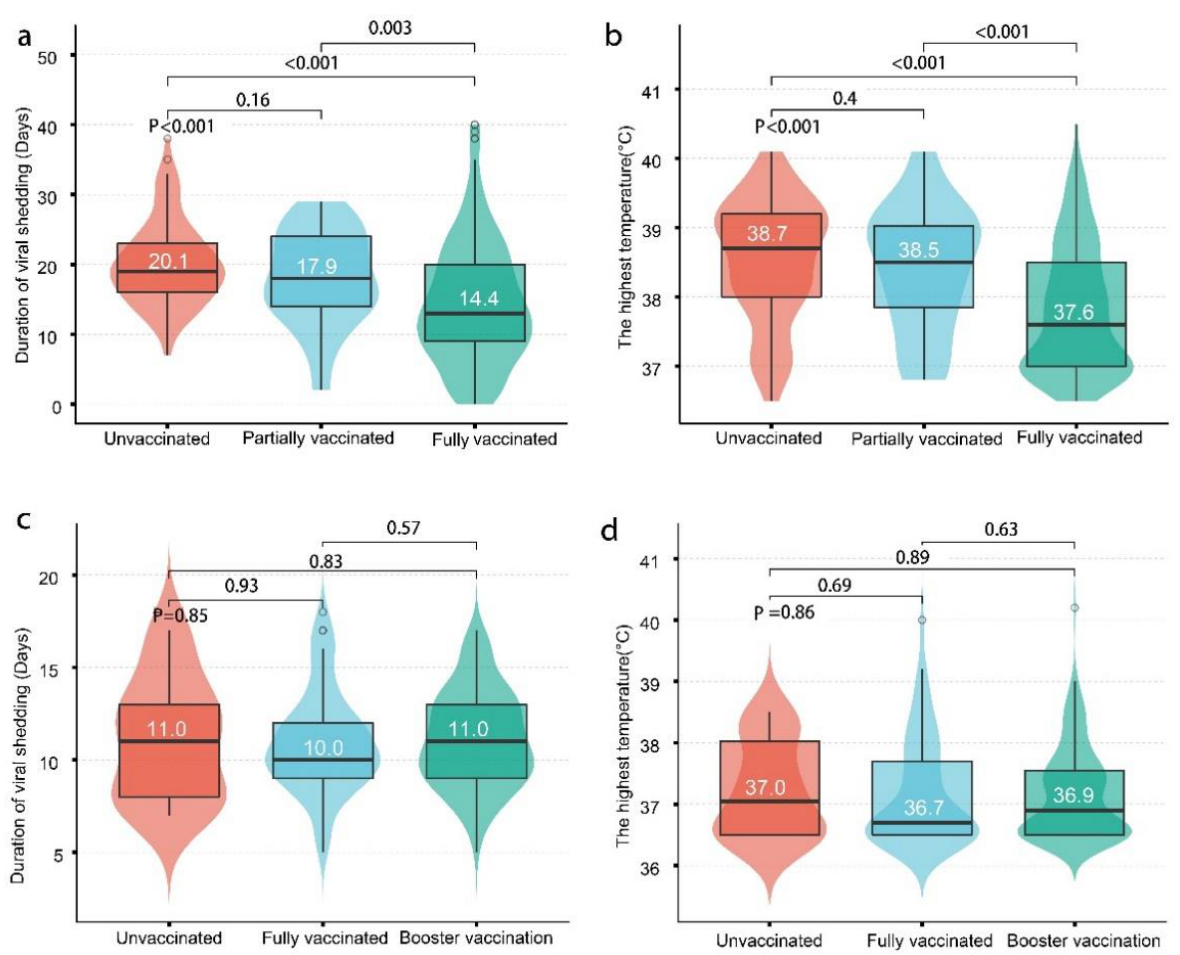
Figure 2. The duration of viral shedding and the highest temperature after Delta ( a , b ) and Omicron ( c , d ) infections. ( a ) The duration of viral shedding and ( b ) the highest temperature in Delta cases. As the dose of vaccines increased, the duration of viral shedding and the highest temperature decreased in Delta cases. ( c ) The duration of viral shedding and ( d ) the highest temperature in Omicron cases. No differences were found between different vaccination groups in the highest temperature or duration of viral shedding in Omicron cases. Boxes depict the interquartile range (IQR) and contain the median (black line) with whiskers spanning 1.5 times the IQR. The shaded area reflects the data distribution.